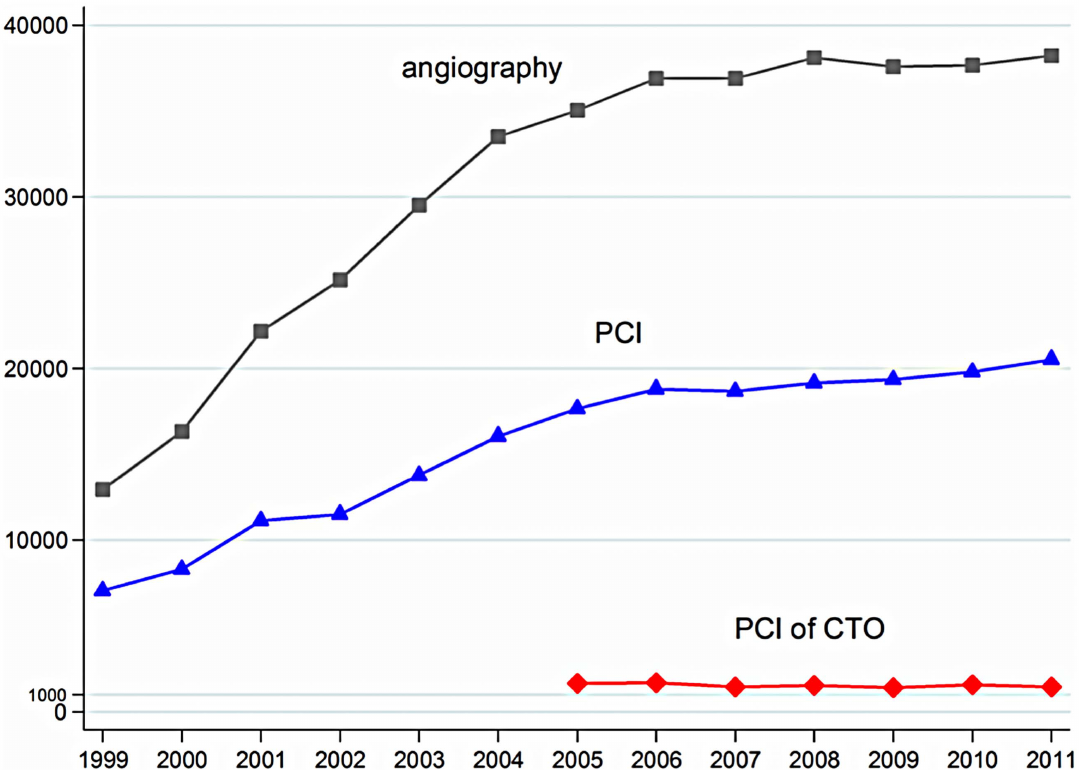
Figure 2. Annual number of coronary angiographies, PCI’s, and PCI’s performed in CTO patients in Sweden reported in SCAAR since 1999.